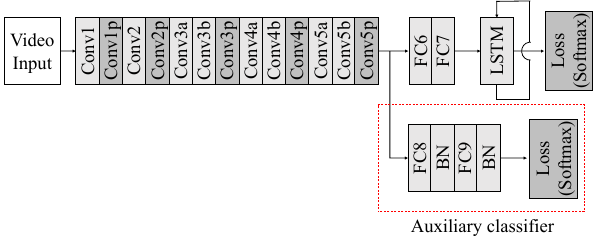
Figure 3. Structure of 3D CNN with auxiliary classifier.